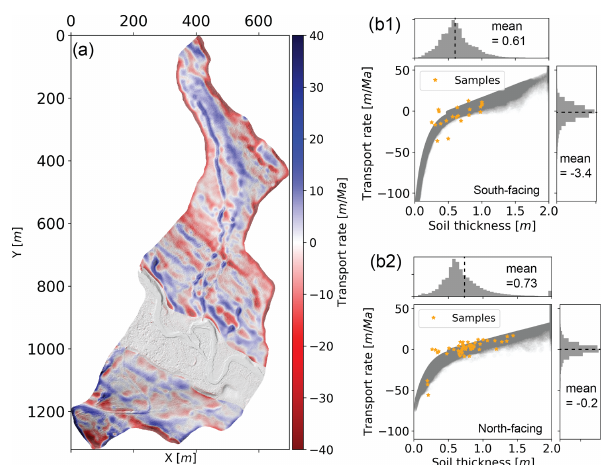
Figure 7. Map of soil surface transport rate. (a) Spatial map of soil transport rate from modeling results. (b1, b2) Relationship between soil thickness and transport rate for the south-facing and north- facing hillslopes, respectively. Positive values of transport rate rep- resent deposition, while negative values represent erosion. The or- ange dots represent the soil thickness from field